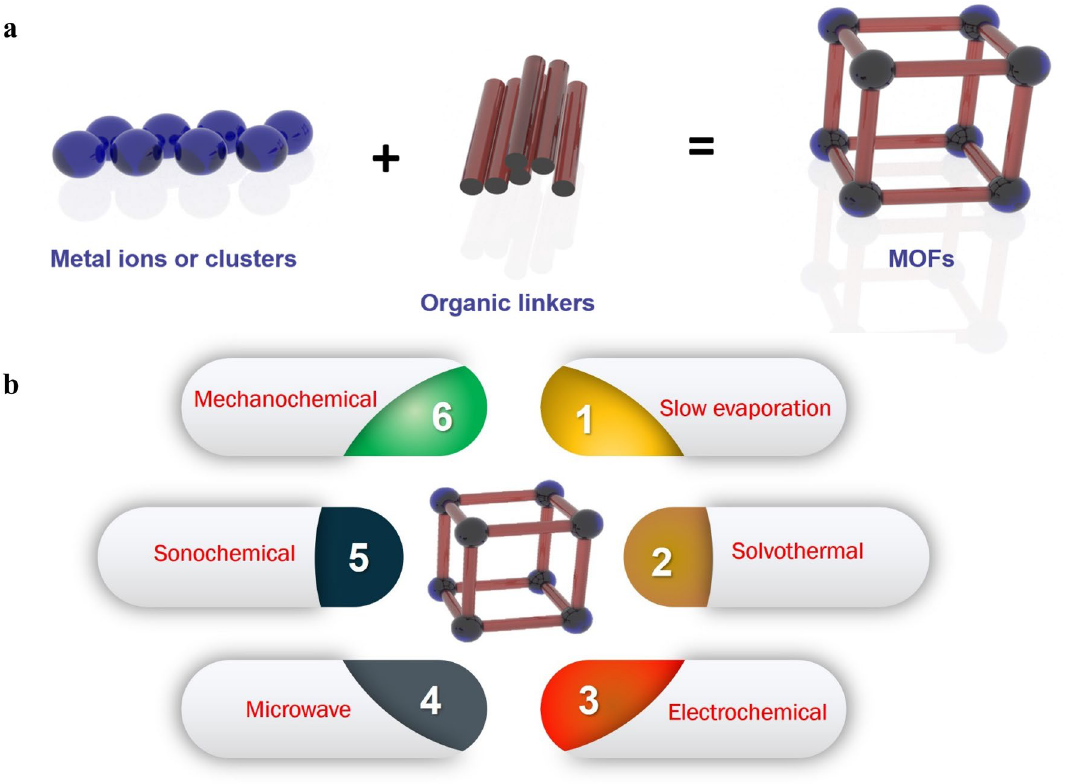
Fig. 1 a Illustration of the building blocks and structure of MOFs. b Methods commonly used for as-prepared MOF